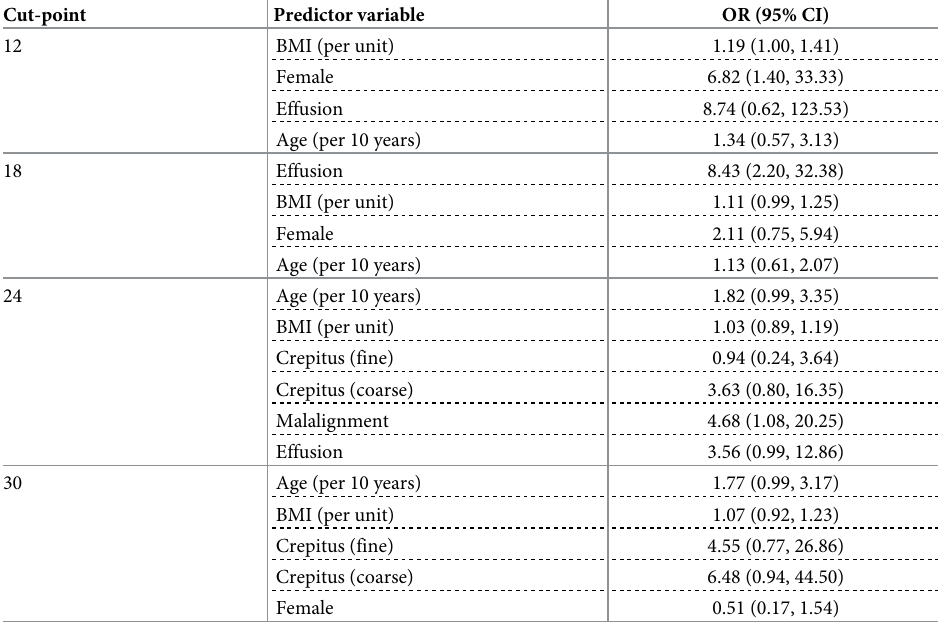
Table 6. Odds ratios (OR) for OA-COM score models in physical exam/history